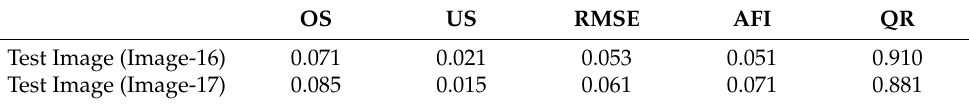
Table 5. Segmentation quality metrics for Zurich Summer